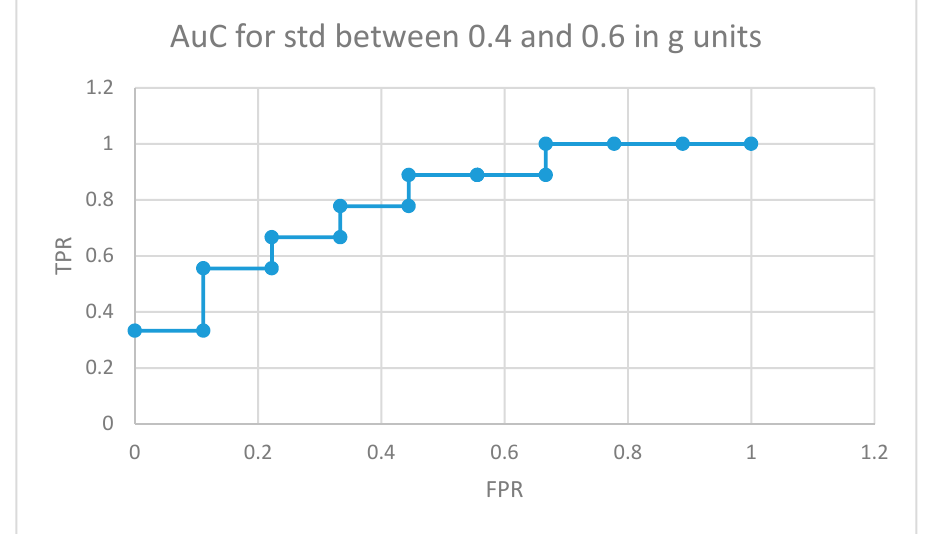
Figure 9. AuC for non-medicated participants with ADHD for movement fragments with the combined standard deviation between 0.4 and 0.6 in g units.